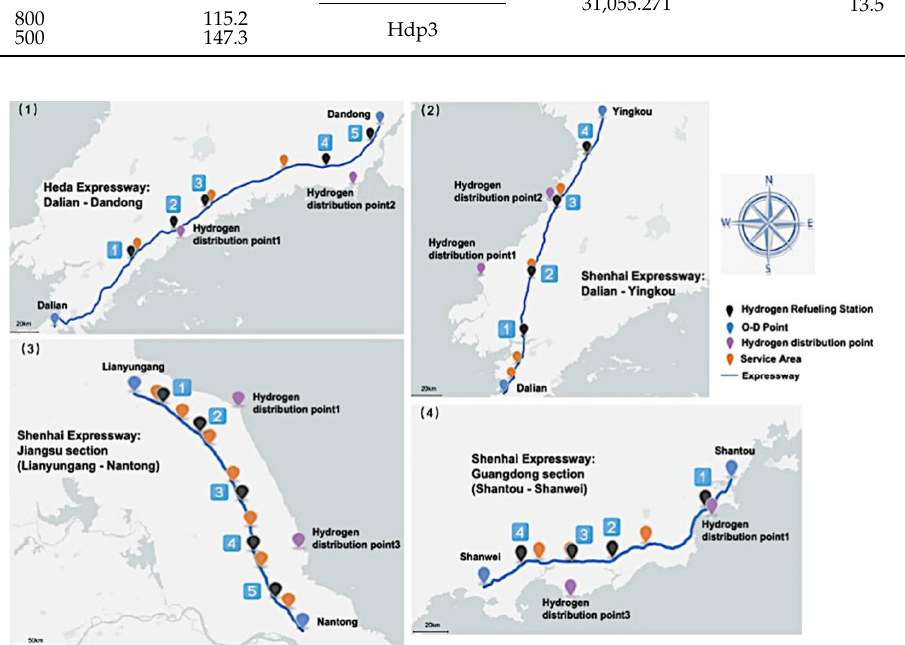
Figure 10. Location optimization result of Scenario 2 (Note: This map is made based on the stand- ard MAP GS(2021)6375 of AmAP, and the base map is not modified). ( 1 ) Location optimization result of Scenario2 in Dalian-Dandong section. ( 2 ) Location optimization result of Scenario2 in Dalian-Yingkou section. ( 3 ) Location optimization result of Scenario2 in Jiangsu section. ( 4 ) Location optimization result of Scenario2 in Guangdong section.